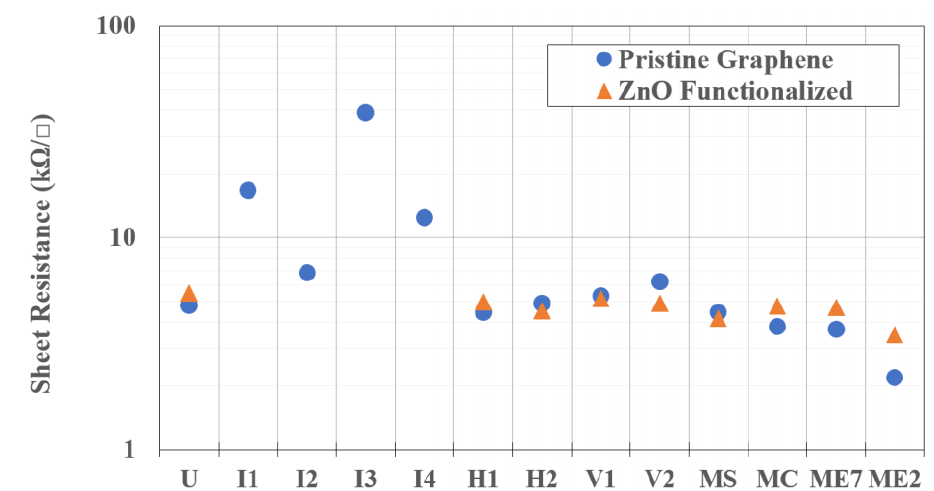
Figure 4. Sheet resistance, accounting for internal etched features, of different geometries on pristine and ZnO functionalized graphene as calculated from data extracted from TLM measurements and graphene features. Table 4. Effective contact area calculated from the device channel width and film contact transfer length L T as derived from TLM data, contact resistance ( R C ), and calculated sheet resistance ( R sh ) of pristine and functionalized graphene device structures after correcting for constricted width values of the different device geometries (open cells indicate devices not studied).